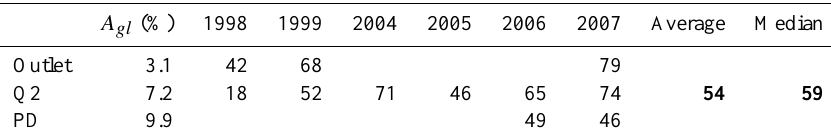
Table 3. Prediction of relative groundwater contribution (%) during the dry season at the Querococha watershed outlet, Q2, and PD mixing points. Empty cells indicate insufficient data.